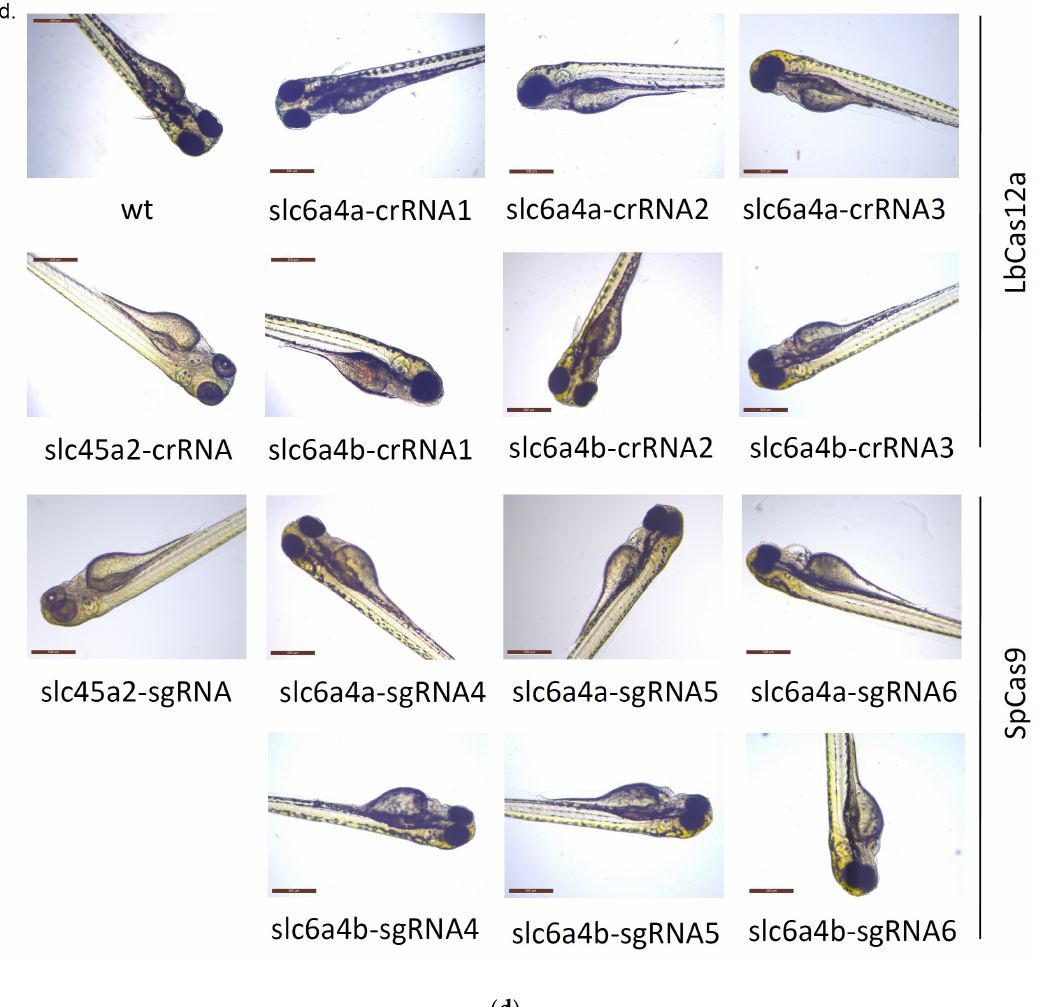
Figure 2. Assessment of crRNAs activities: ( a ) schematic representation of the protospacer location in the exon 1 of slc6a4a gene; ( b ) schematic representation of the protospacer location in the exon 1 of slc6a4b; ( c ) in vitro activity assessment of ribonucleoprotein complexes of LbCas12a with corresponding crRNAs: percentage of PCR-products that were cut by RNP complexes is given in the row under the picture; ( d ) representative phenotypes of RNP-microinjected embryos.